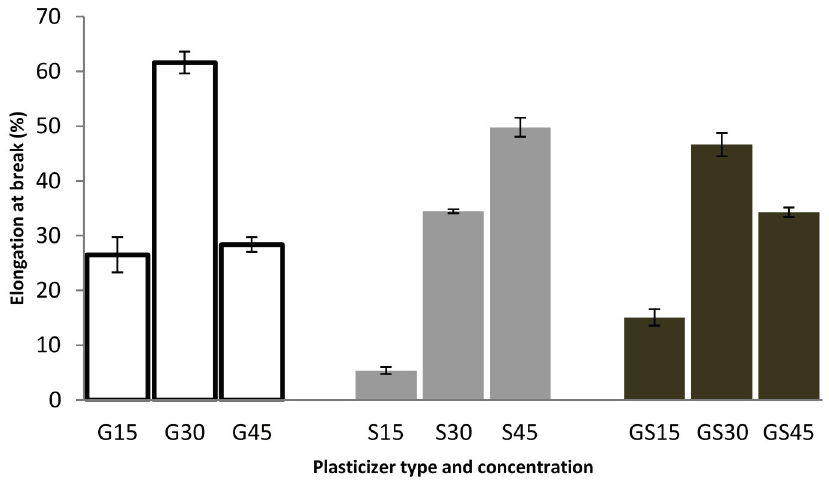
Figure 2. Effect of plasticizer type and concentration on the tensile strength of SPS